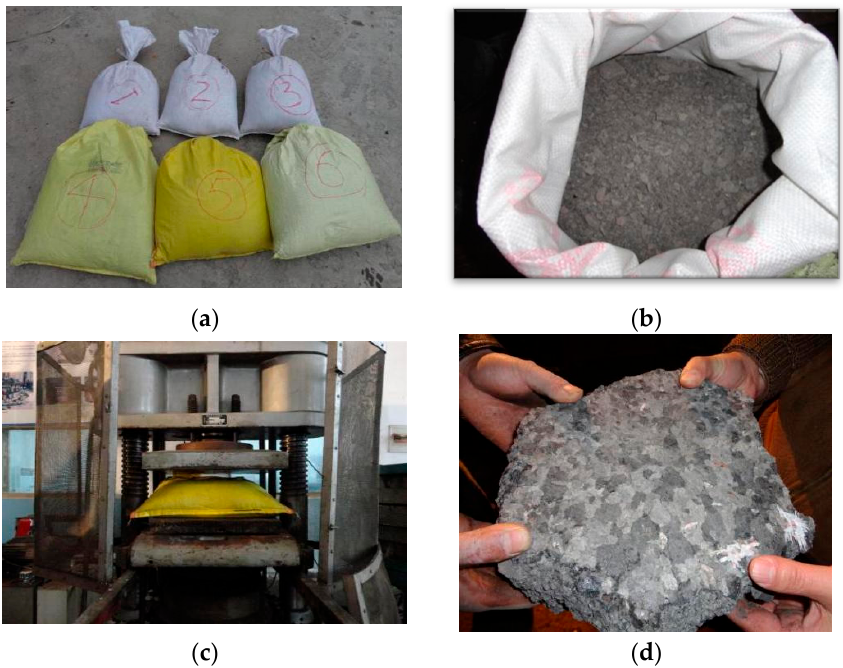
Figure 3. Field diagram of the stress-and-strain experiment of packed gangue; ( a ) coal gangue woven bags of different size; ( b ) particles of crushed coal gangue for experiment; ( c ) CSS-YAW3000 electronic universal testing machine; ( d ) compacted coal gangue block.